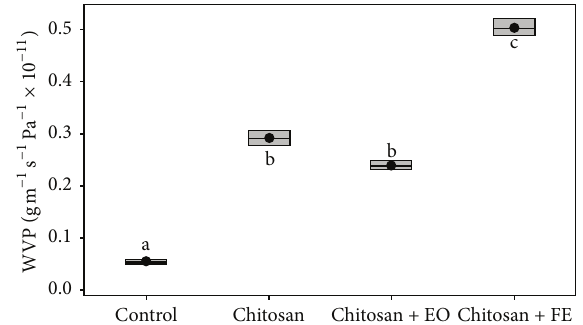
Figure 4: Water vapour permeability of the edible films including essential oils and functional extract of clove. Data are means of three replicates per